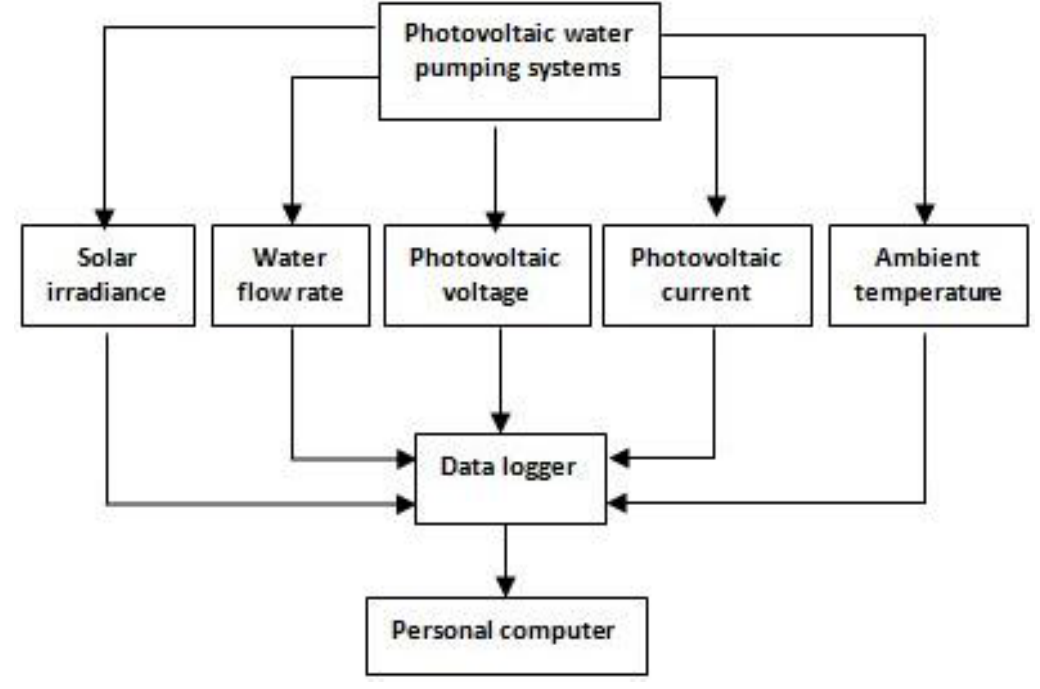
Figure 1. Data from the PV water pumping station to the personal